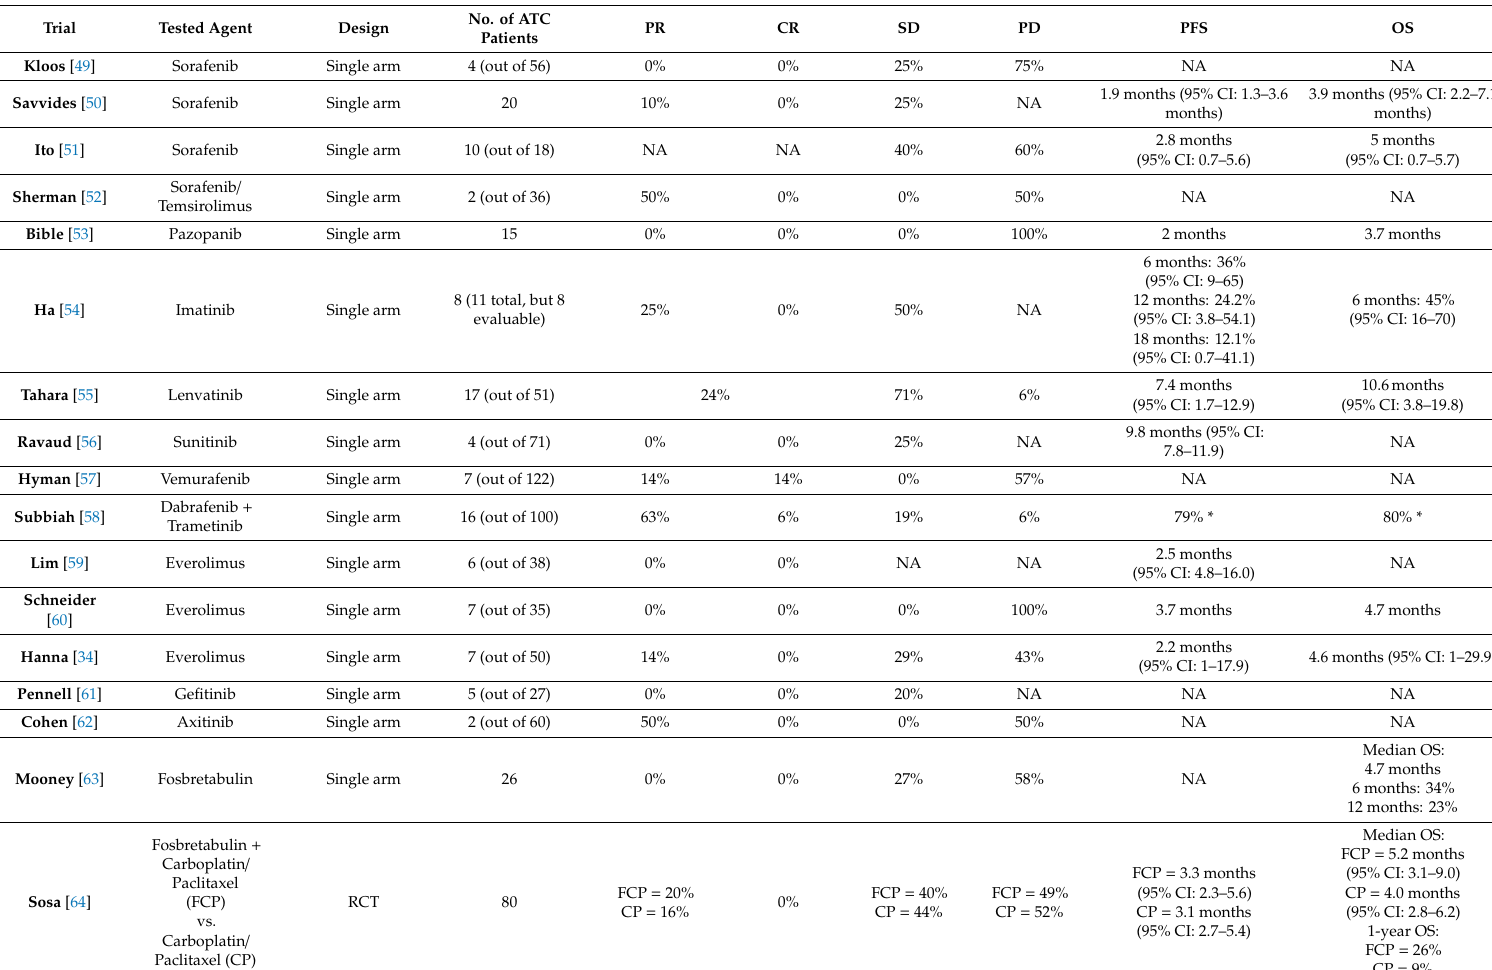
Table 2. E ffi cacy results in phase II clinical trials of targeted therapy in